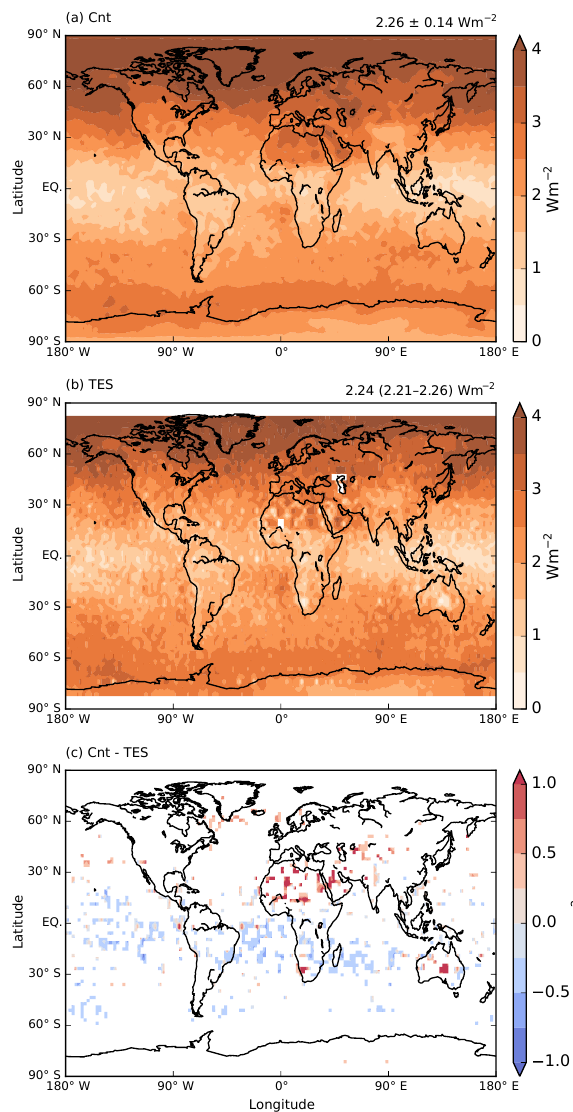
Figure 2. Comparison of the annual mean ozone radiative effect between (a) the Cnt simulation and (b) the Tropospheric Emis- sion Spectrometer (TES) from July 2005 until June 2008 (05– 08). The annual global mean is shown on the top right corner (Wm − 2 ) . (c) Cnt simulation bias compared to the TES. Differences are masked for the ± 1.96SE within the 3-year observed